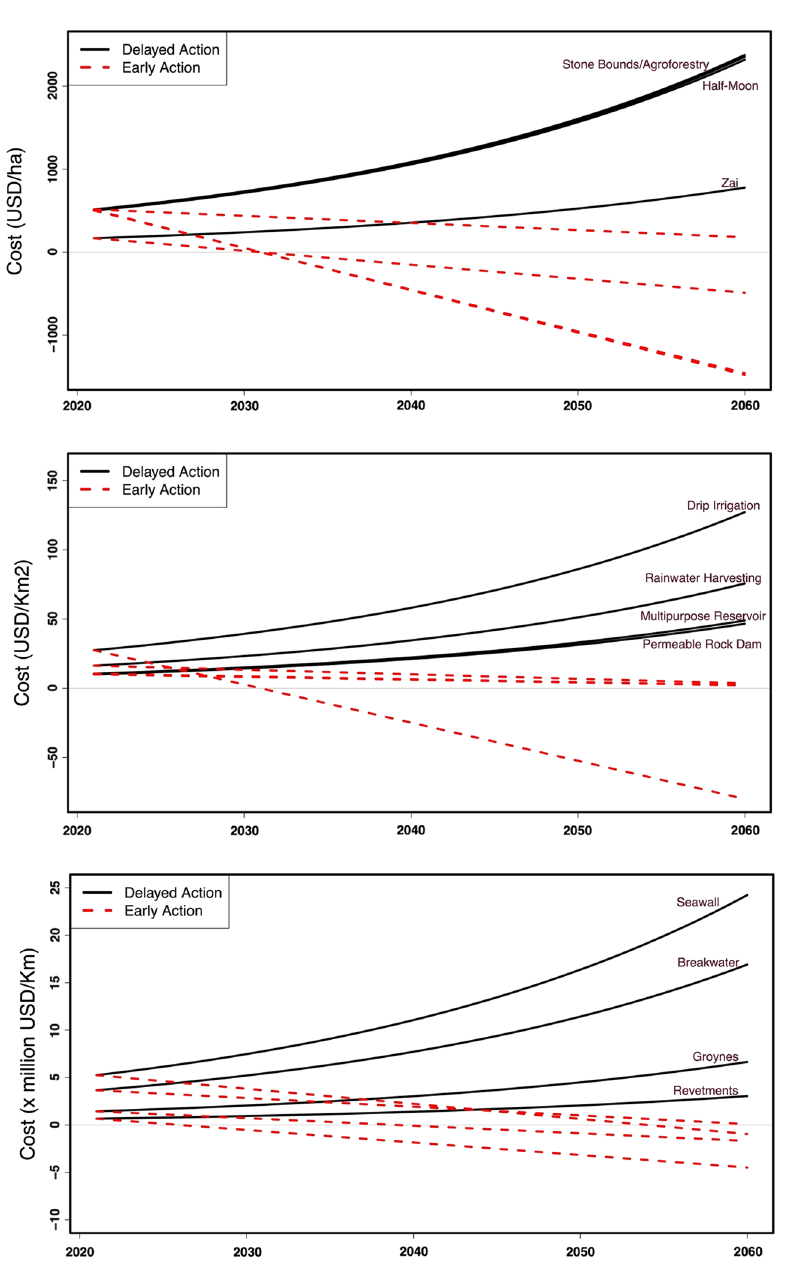
Figure 4. Projected costs of delayed (early with depreciation) implementation of adaptation measures when applied to crop management, water management, and the protection of coastal